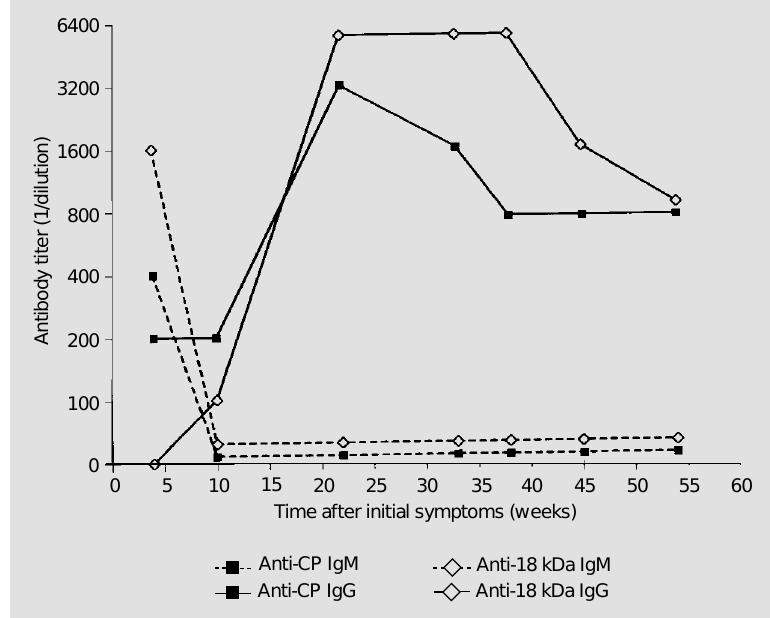
Figure 1 - Antibody response to LPS-free cytosolic proteins (CP) and the 18-kDa protein in acute human brucellosis. Prototypical pattern found in a patient diagnosed 30 days after the onset of